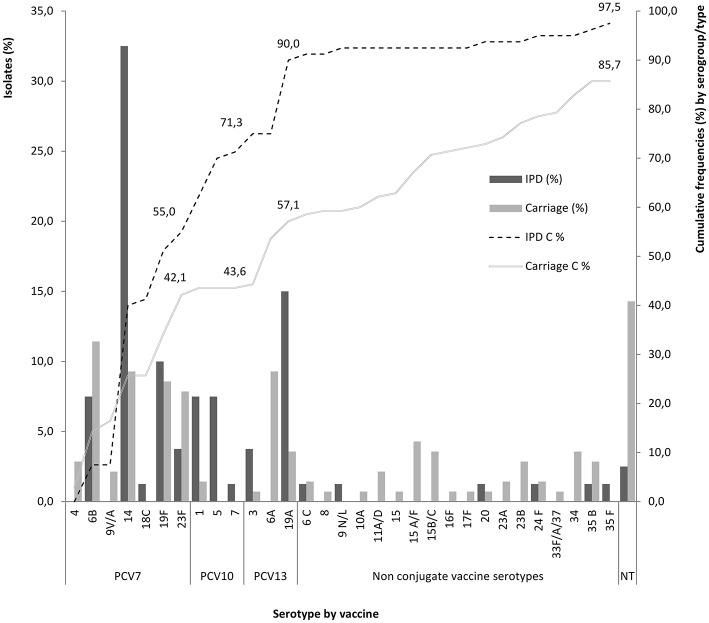
Rate of serogroup/type cumulative coverage (C %) in each conjugate vaccine (PCV7, PCV10, PCV13) for S. pneumoniae recovered from invasive pneumococcal disease (IPD) and asymptomatic carriers less than 5 years old, from Algeria. NT, non-typeable.